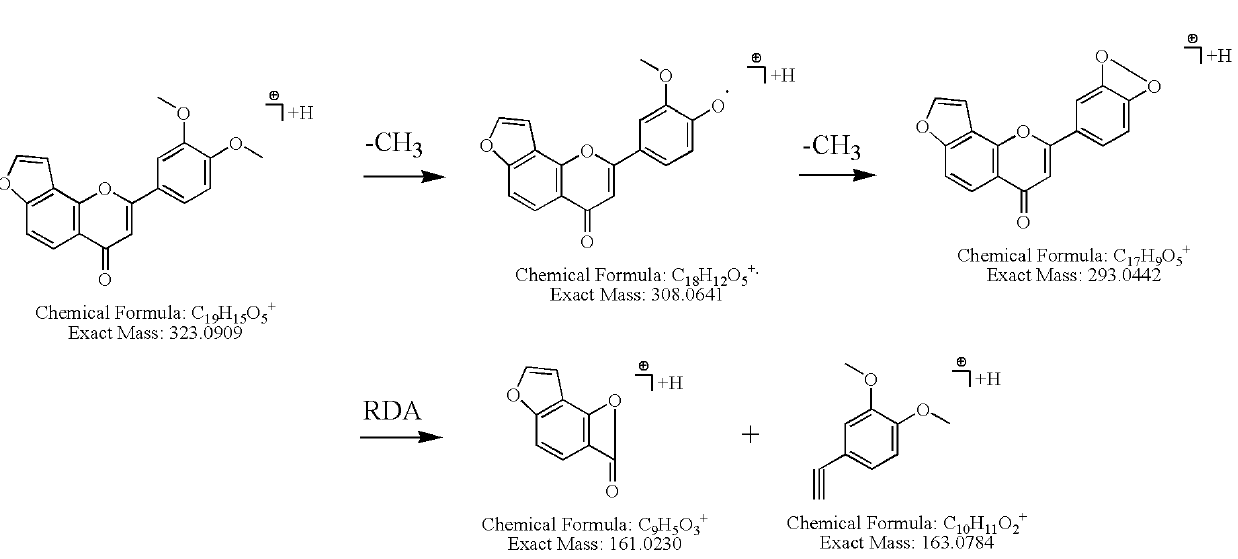
(Table 1). In their MS 2 spectra, the characteristic ions at m/z 294.05 (C 176.01 (C H O , 1,3 A + ) were detected in compound 4 , while the characteristic ions at m/z 9 4 4